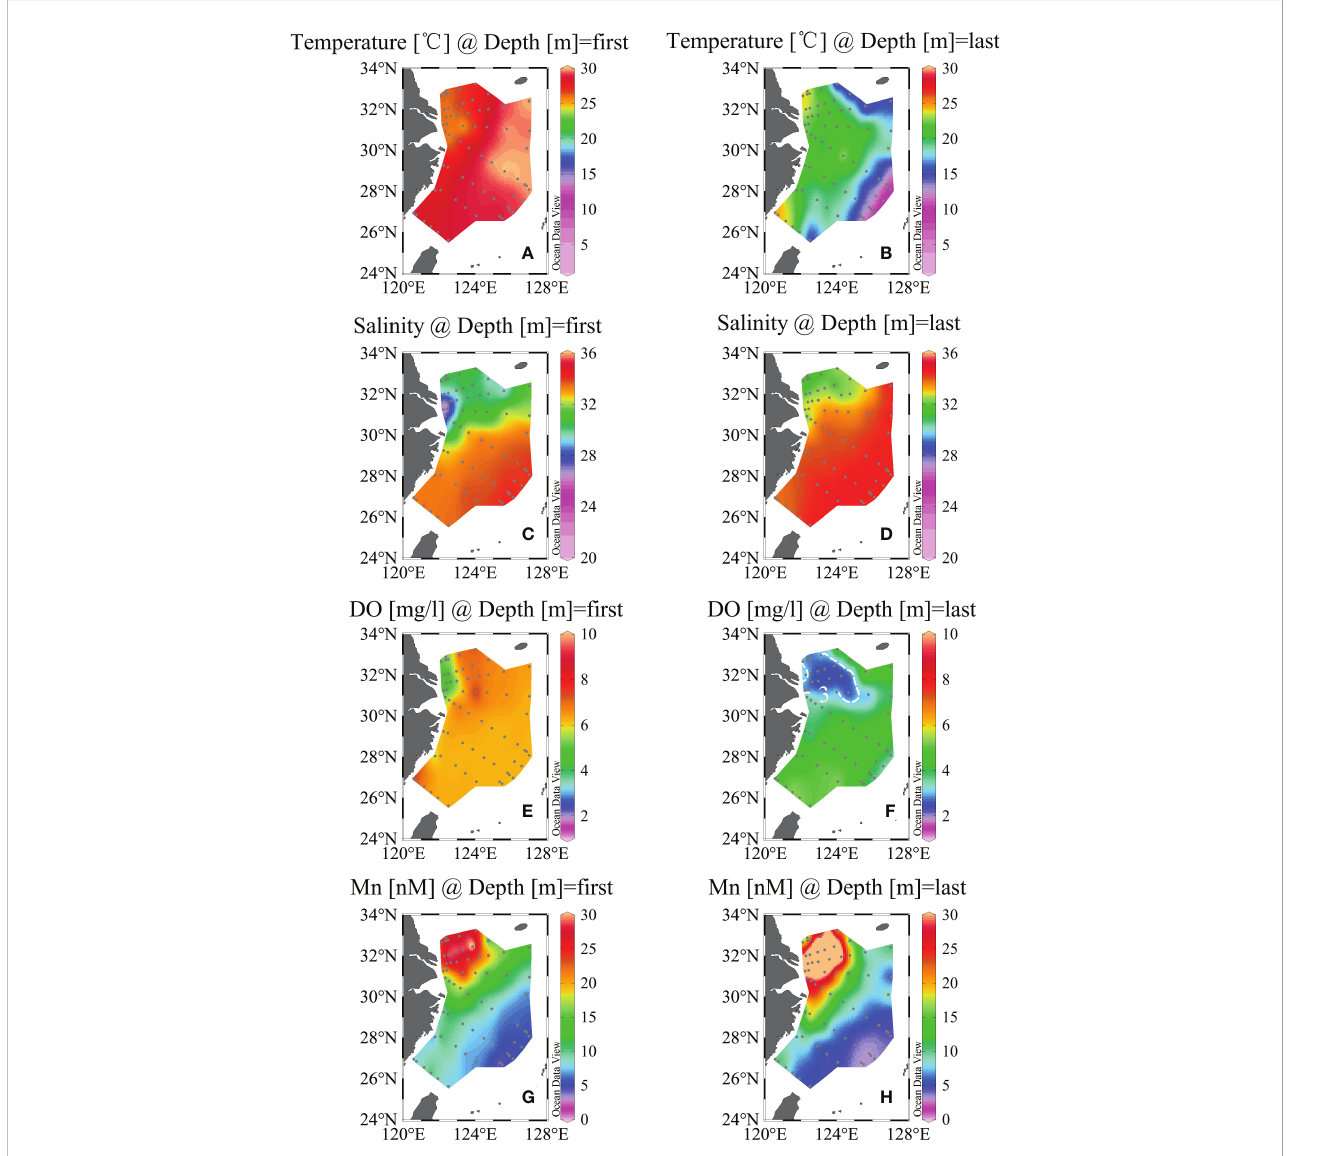
FIGURE 4 Horizontal distributions of temperature (°C), salinity, dissolved oxygen (DO, mg/L), and dissolved Mn (nM) in the surface (A, C, E, G) and the bottom layers (B, D, F, H) in the East China Sea in August